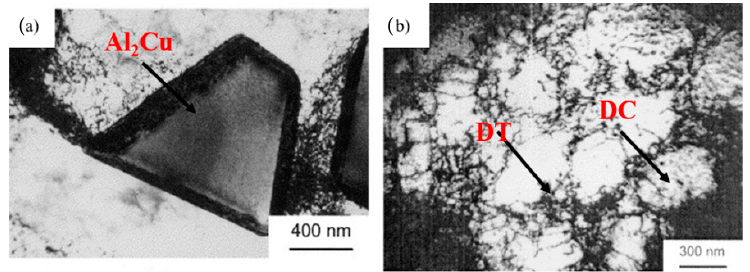
Figure 6. TEM showing ( a ) trapezoidal Al 2 Cu particle as emission source of dislocations ( b ) DC and DT in the aluminum matrix. Reproduced with permission from [38]. Copyright Elsevier, 2002.